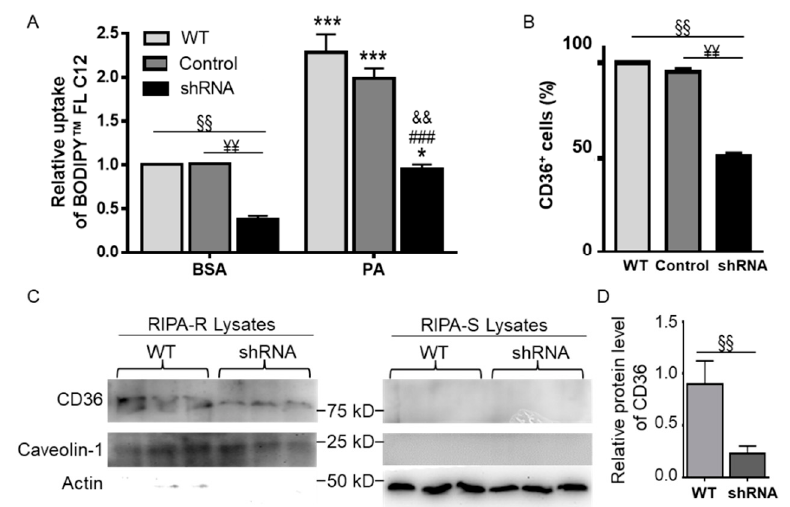
Figure 6. BODIPY TM FL C12 uptake in N2a cells stably transfected with CD36 shRNA. ( A ) Wildtype (WT), non-mammalian control shRNA-transfected (control), and CD36 shRNA-transfected cells (shRNA) were treated with BSA or 200 µM PA for 6 h. BODIPY TM FL C12 uptake was then examined by flow cytometry. Data were analyzed using two-way ANOVA followed by Tukey’s multiple comparison test. ( B ) Detection of CD36 surface expression in WT, control, and CD36 shRNA cells by immunostaining with APC-Vio ® 770-conjugated anti-mouse CD36 followed by flow cytometry. Data were analyzed using t-test. ( C , D ) Detection of CD36 protein by Western blot assay. WT and CD36 shRNA cells were lysed in RIPA buffer, and the soluble fraction was collected as RIPA-S. The RIPA-insoluble fractions (RIPA-R) were solubilized by 10% SDS. Both fractions were subjected to Western blot analysis and detected by CD36, Caveolin-1, and actin antibodies with Western blot images shown in ( C )and quantitated data shown in ( D ). Data were analyzed using t-test. ¥¥ p < 0.01 within comparison groups; §§ p < 0.01 within comparison groups; * p < 0.05 vs. corresponding BSA- treated control cells; *** p < 0.001 vs. corresponding BSA-treated control cells; ### p < 0.001 vs. 200 µM PA-treated WT cells; && p < 0.01 vs. 200 µM PA-treated non-mammalian control shRNA-trans- fected cells.